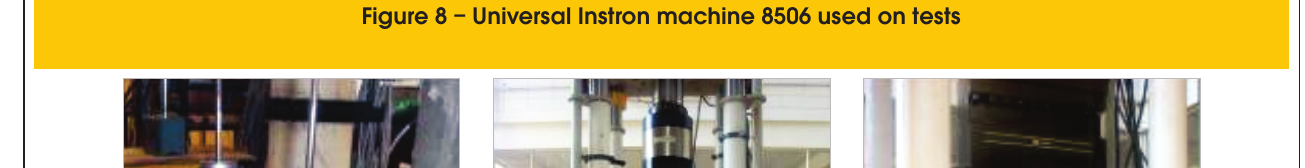
Figure 8 – Universal Instron machine 8506 used on